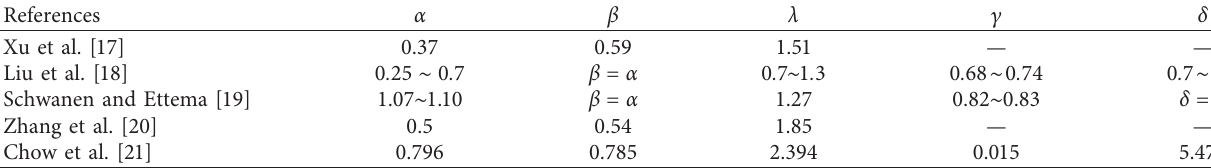
Table 1: Summary of parameters calibration results of travel behavior.